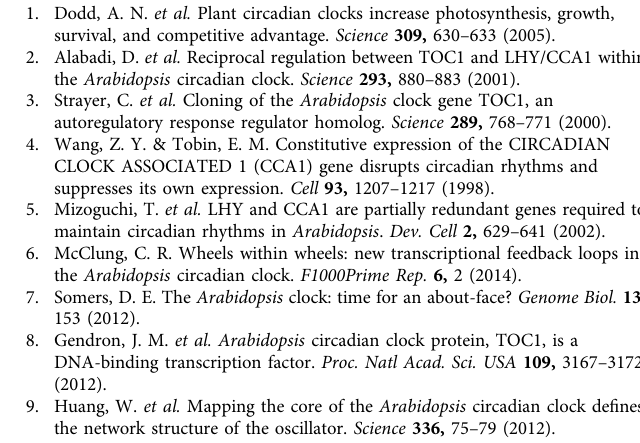
Table 2. The comparative C T method was used to determine the relative gene expression, with the expression of UBQ10 or UBC21 as the internal control. Mean values of 2 (cid:3) D CT ( D C T ¼ C T, gene of interest – C T, UBQ10 or UBC21 ) were calculated from three technical repeats. Independent biological replicates of qRT-PCR results are shown in Supplementary Fig.